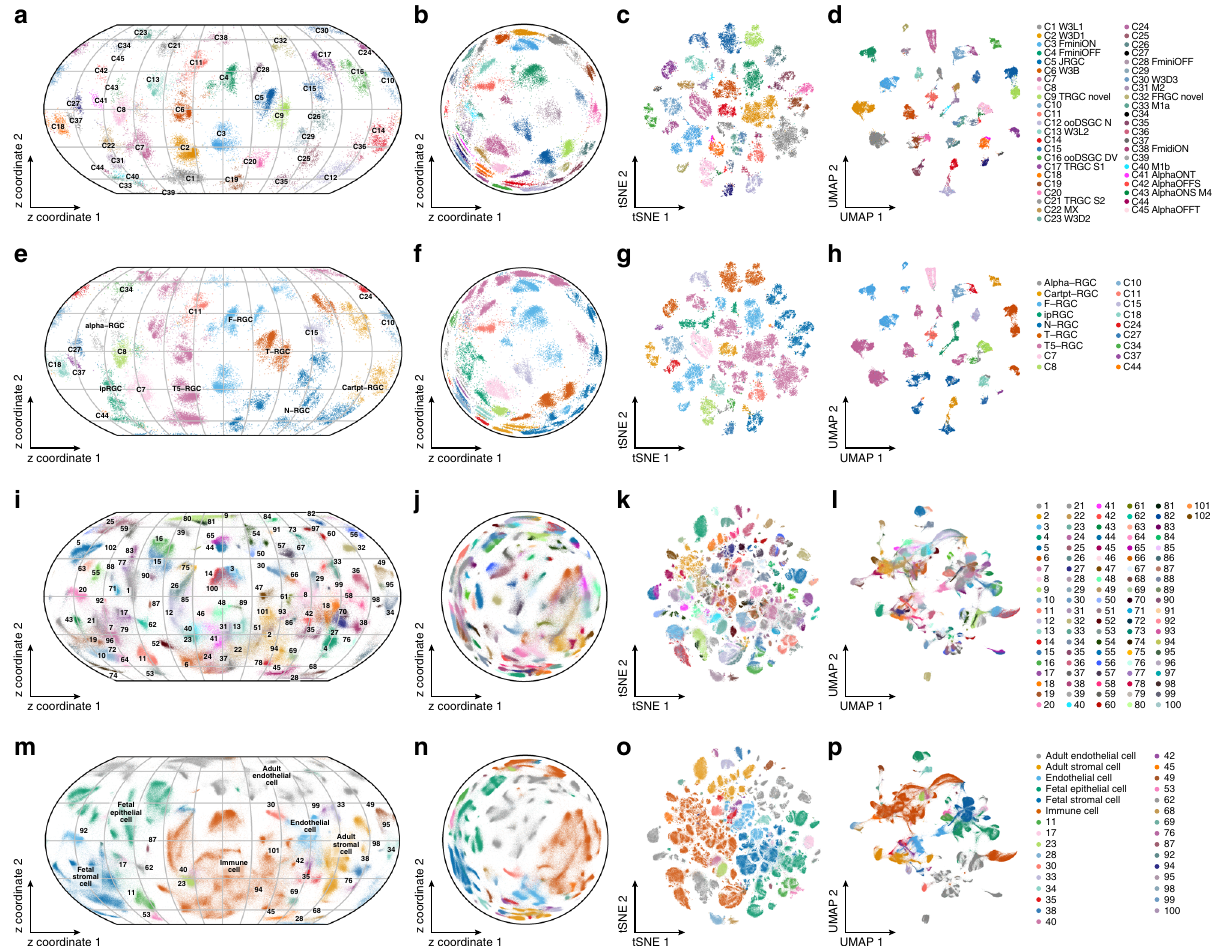
Fig. 2 ScPhere resolves the cell-crowding problem and preserves hierarchical global structures in visualizing large scRNA-seq data. a – p ScPhere learns latent representations that provide excellent visualization of local and global structure, even in very large datasets. Shown are scPhere posterior means of cells in a sphere projected to 2D by the Equal Earth map projection method ( a , e , i , m ), scPhere learned representations in the Poincaré disk ( b , f , j , n ), 2D t - stochastic neighborhood embeddings ( t -SNE) ( c , g , k , o ), and 2D uniform manifold approximation and projections (UMAP) ( d , h , l , p ), for 45 mouse retinal ganglion cells (RGCs) ( a – h ), and 102 Human Cell Landscape clusters ( i – p ) with cells colored by either cluster membership ( a – d , i – l ), or by major cell types ( e – h , m – p ; clusters that cannot be assigned to major cell types are (Supplementary Fig. 2b – d), with some minor challenges (e.g., stromal cells, and immune cells) (Fig. 2m, n), but were more mixing of mouse adipose doublets and macrophages by UMAP, spread in different parts of the t -SNE and UMAP representations Supplementary Fig. 2c), and PHATE — designed for development (Fig. 2o, p). ScPhere outperformed other methods in preserving trajectories — connecting cells inaccurately when only discrete cell the hierarchical global structure, based on global k -NN accuracies types are present (Supplementary Fig. 2d). on both the RGC and the HCL datasets (scPhere: 73.53% and 92.21%, t -SNE: 47.06% and 79.22%; UMAP:52.94% and 83.12%, Supplementary Fig. 3b, e, “ Methods ” ). Moreover, with this large number of cells, t -SNEs were increasingly “ crowded ” 17,18 , such that where even very distinct cell types were very close to each other in 2D (Fig. 2k), and cells from multiple clusters appeared mixed in the UMAP (Fig. 2l), as re fl ected both visually and based on mean Silhouette scores (Mann – Whitney U test, FDR < 0.0001, Supplementary Fig. 3f, “ Methods ” ). ScPhere did not suffer from these problems, partially because it was trained using mini- batches, while t -SNE and UMAP were learned using all the data, and their parameters (especially the perplexity parameter of t - increasing the perplexity parameter makes t -SNE computationally expensive 18 . (In our analyses, we used a list of perplexity parameters that already grow with the number of cells 18 ; the cell- crowding problem suggests that much larger perplexity para- meters are required.) By contrast, scPhere was trained with